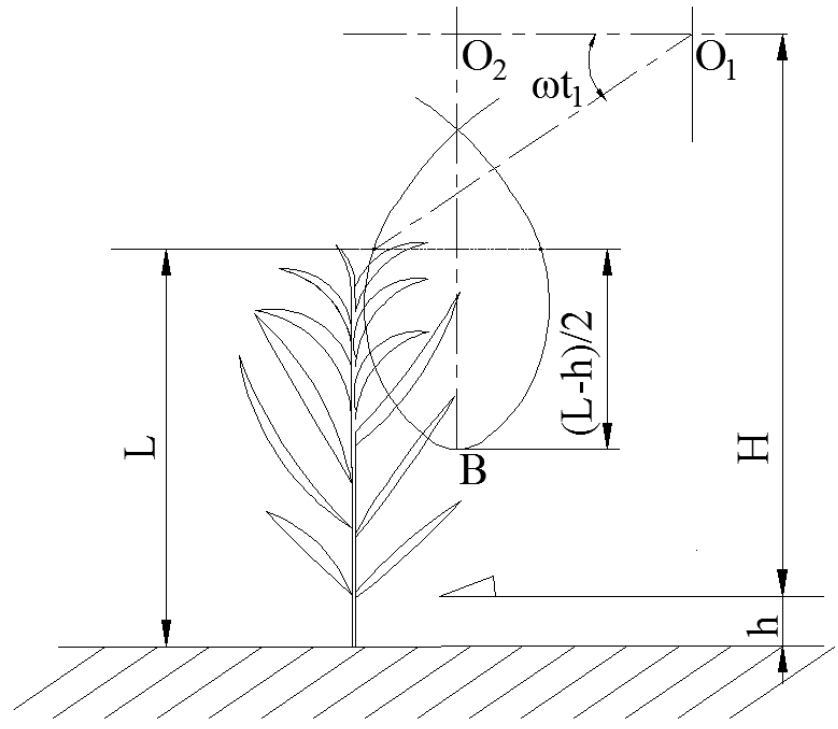
Figure 4. Diagram of operating parameters of the dial reel.